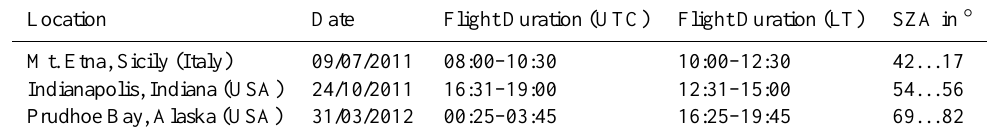
Table 9. List of flights from which data is presented in this article.